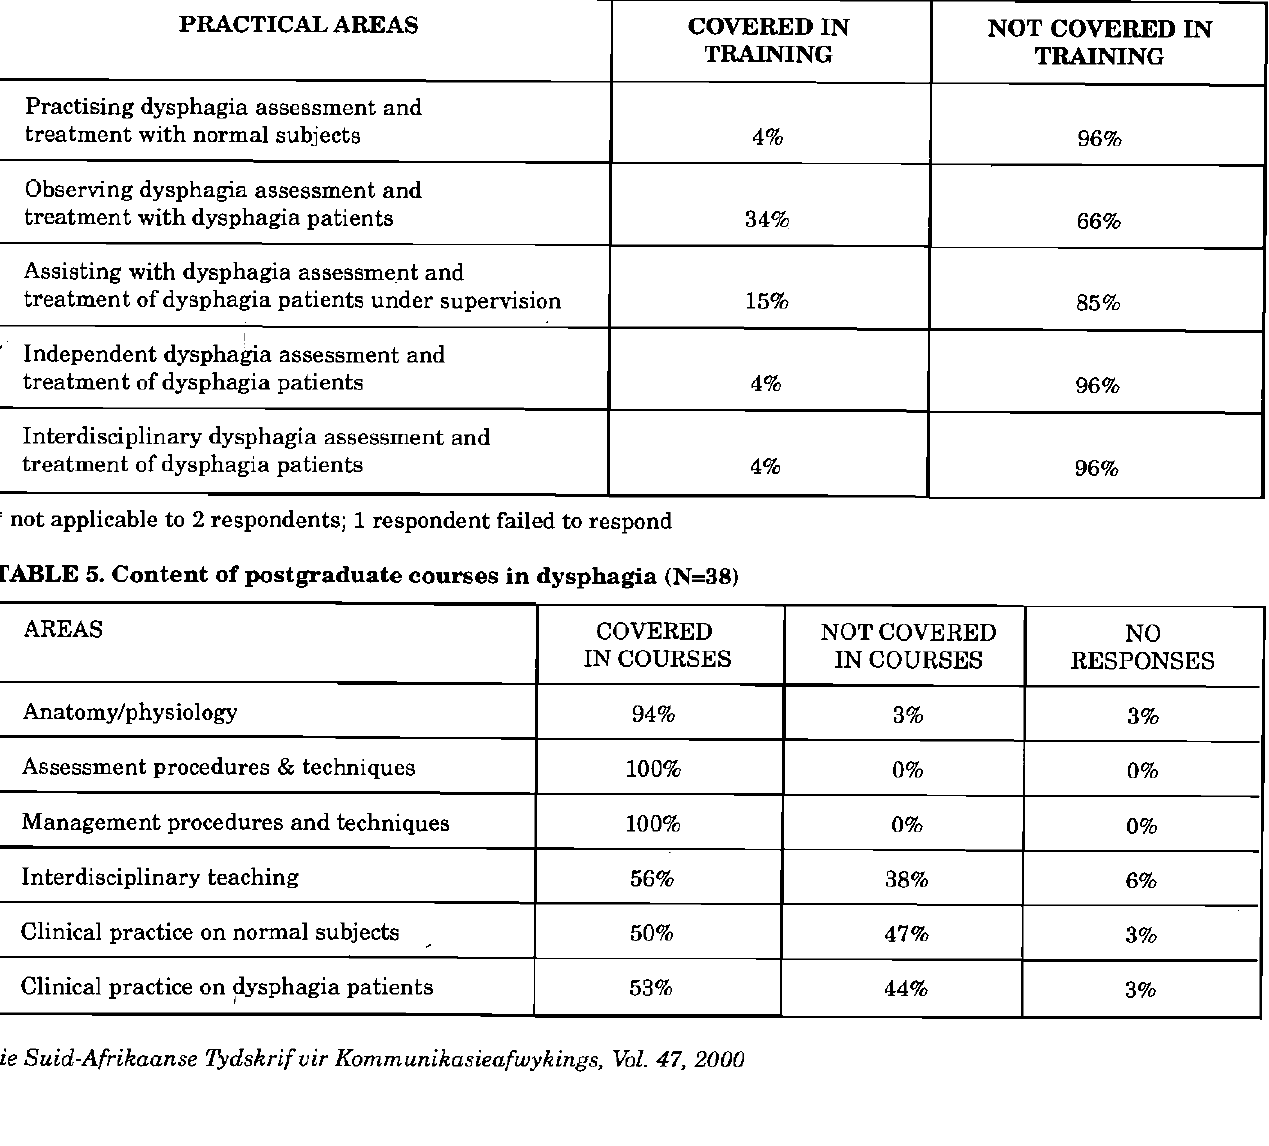
TABLE 4: Practical training in dysphagia at an undergraduate level (N=47)* PRACTICAL AREAS